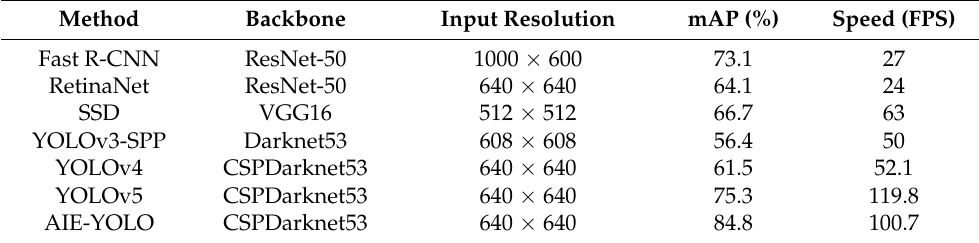
Table 3. Comparisons of accuracy and speed on the TT100K testing